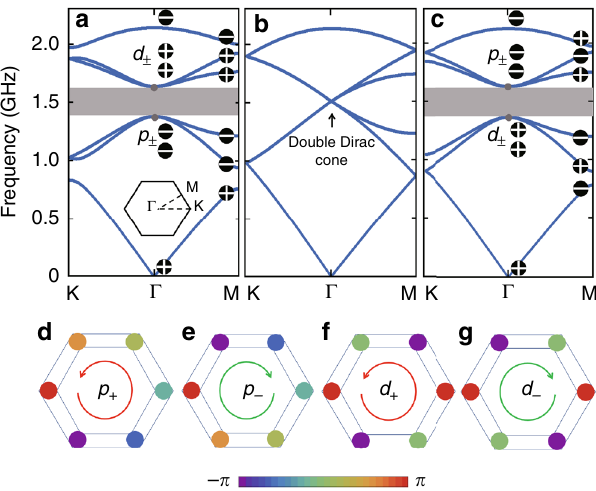
Fig. 2 Band structures and topological phase transition in LC circuit. Frequency band structures calculated based on Equations (2) and (3) for a τ < 1 with L 0 = 3.60 nH and L 1 = 6.35 nH, b τ = 1 with L 0 = L 1 = 4.22 nH, and c τ > 1 with L 0 = 5.09 nH and L 1 = 3.13 nH. The on-node capacitance is taken as C = 7.27 pF for all three cases. The distributed inductances and lumped capacitance are taken as tuning parameters, which reproduce the frequency band gap and the gap-center frequency of the experimental setup. The values of the distributed inductances are close to those evaluated from the experimental structures of microstrip arrays, and the on-node capacitance is slightly larger than the lumped one due to the distributed capacitances coming from the microstrip lines. The signs “ + ” and “ − ” inside the black dots denote the parities of the eigen EM modes with respect to the two-dimensional spatial inversion at the high-symmetry Γ point and M point of the Brillouin zone. d – g Phase distributions of the out- of-plane electric fi eld E z for the four eigenmodes at the Γ point close to the frequency band gap at 1.515 GHz in ( a , c